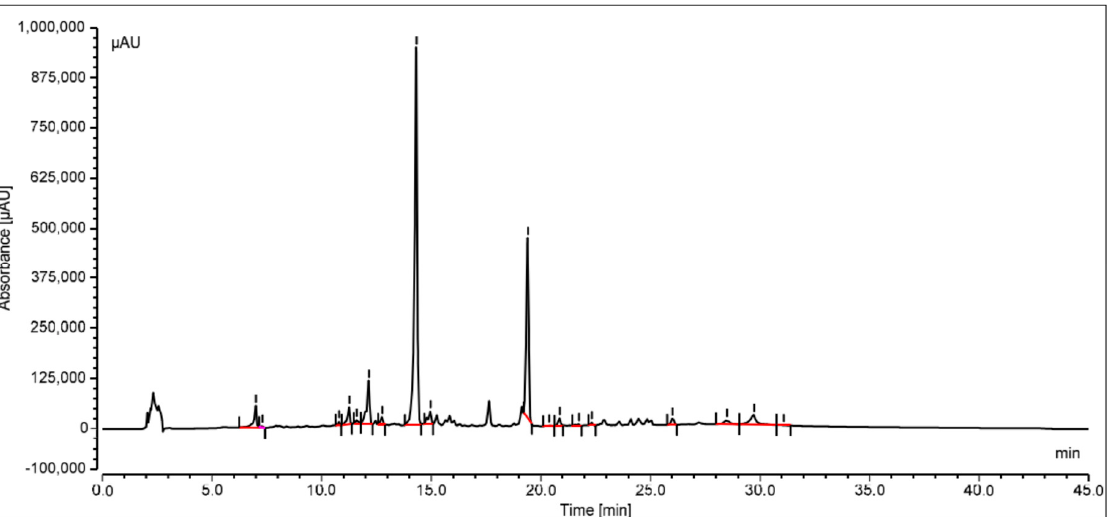
Figure 4. HPLC peak of oleanolic acid of S. mangifera fruit ethanolic fraction visualized at Rt 14.329.